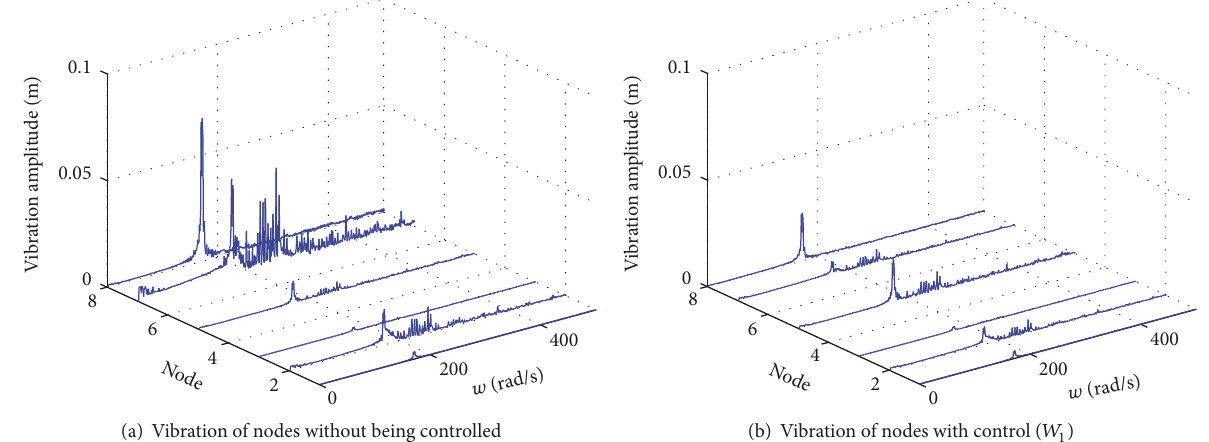
Figure 9: Vibration weighted optimal control effect of nodes 1, 2, 3, 5, 7, and 8.